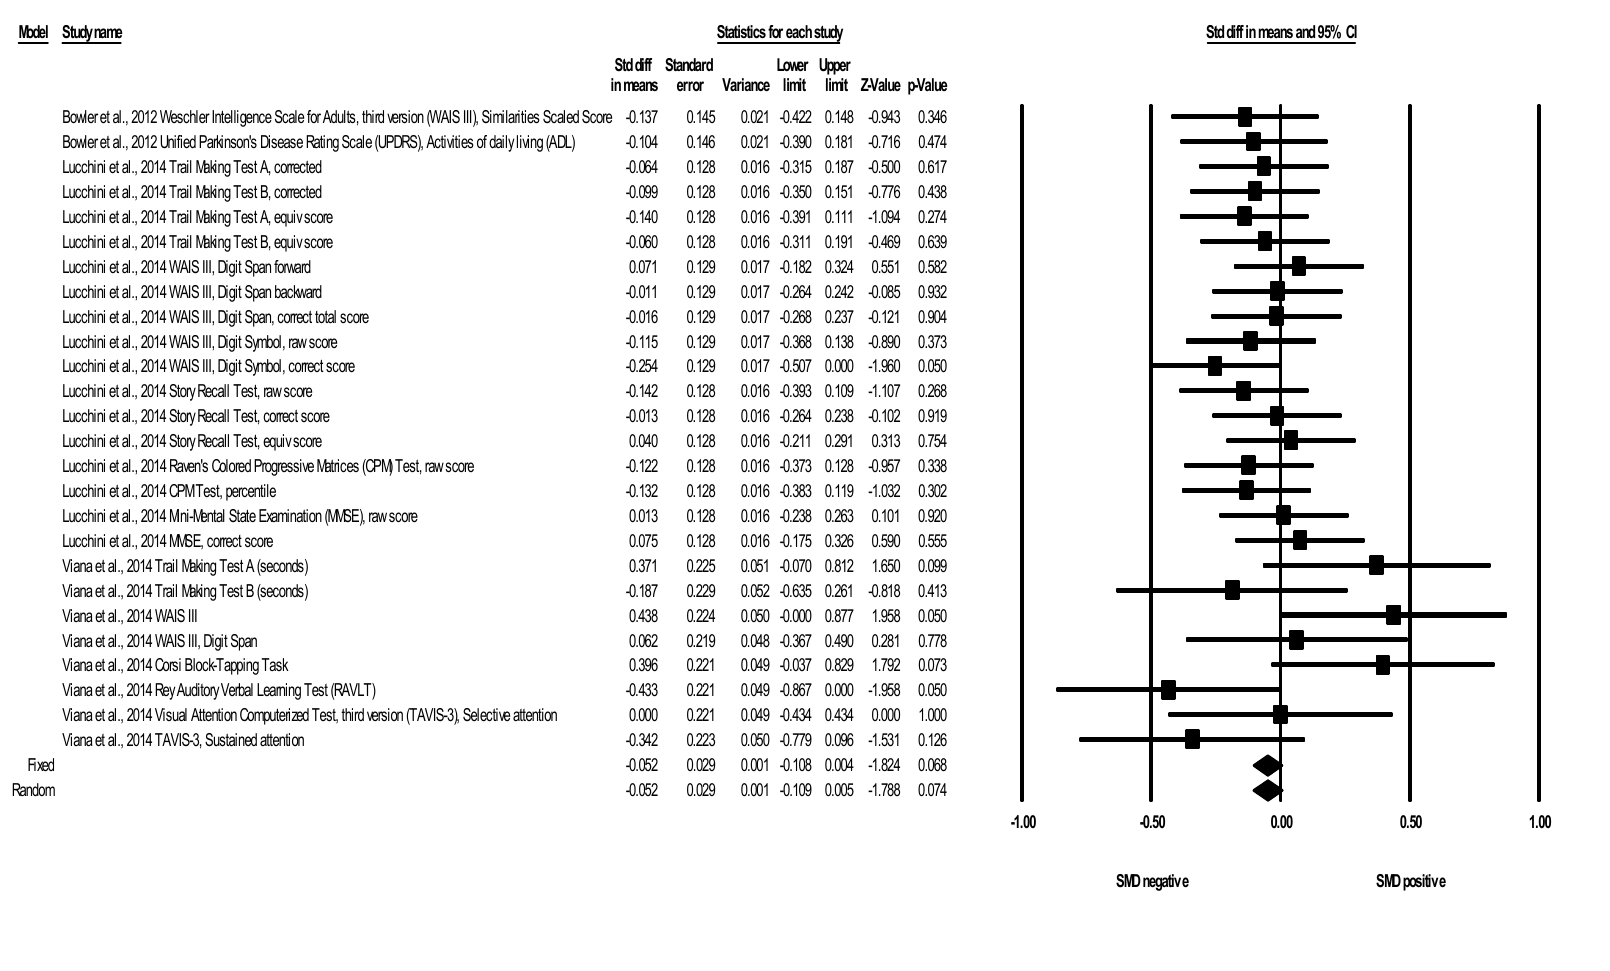
Figure 3. Cognitive function. Standardized mean differences (SMDs) between groups. All tests and all exposures to Mn. Note: a negative SMD indicates that the group with higher Mn levels had worse cognitive function on average.